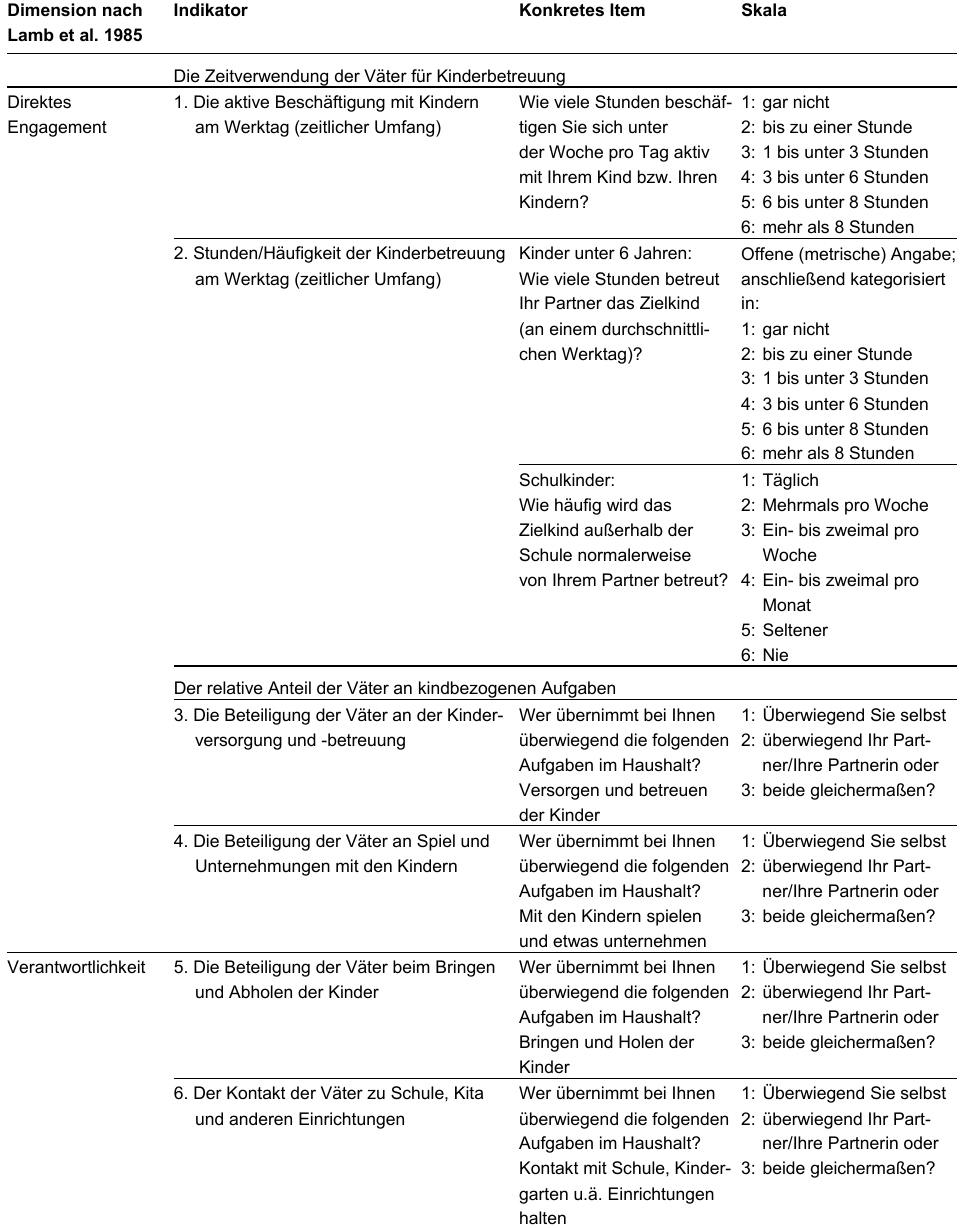
Tabelle 2 : Dimensionen des Indikators ‚aktive Vaterschaft‘ Dimension nach Lamb et al.